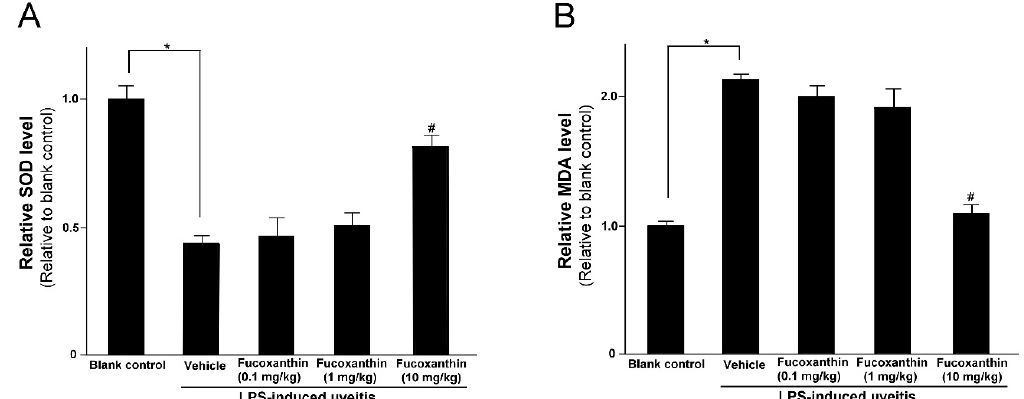
Figure 3. Effects of fucoxanthin on the SOD activity and MDA levels in ocular tissues treated with LPS. Treatment with 10 mg/kg BW of fucoxanthin significantly increased SOD ( A ) and decreased MDA levels ( B ), which were induced by LPS. The results represent the mean ± SD ( n = 5) from five independent experiments. * p < 0.05: Significantly different compared to the blank control group (Student’s t -test). # p < 0.05: Significantly different in the LPS-treated groups (one-way ANOVA followed by Bonferroni’s multiple comparison test).